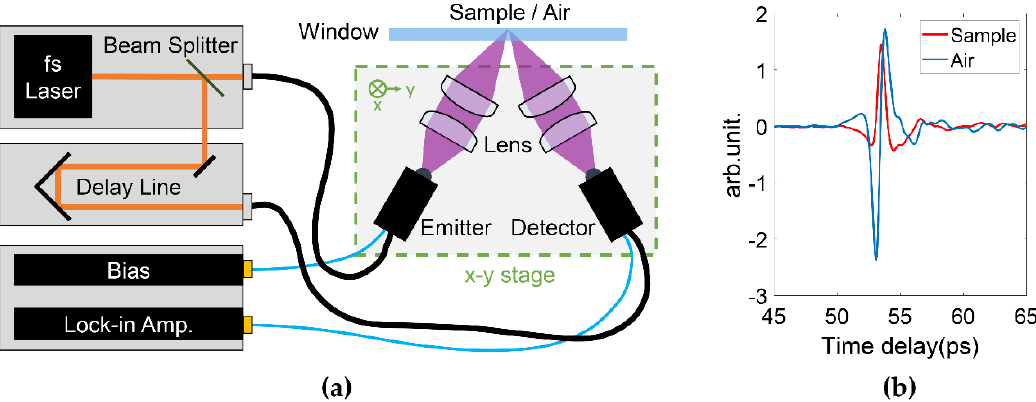
Figure 1. ( a ) Typical THz pulsed laser imaging system in reflection geometry. The THz optical system is assembled on a x-y 2D stage to enable raster scanning the sample. ( b ) Examples of the THz pulses reflected from the quartz-volar forearm and quartz-air interfaces, respectively.